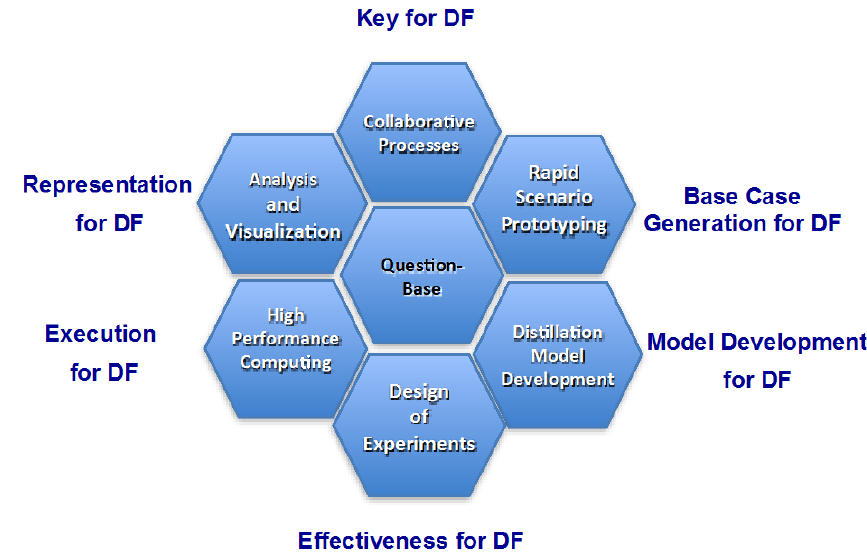
Figure 1. The 6 realms of data farming around a question base .